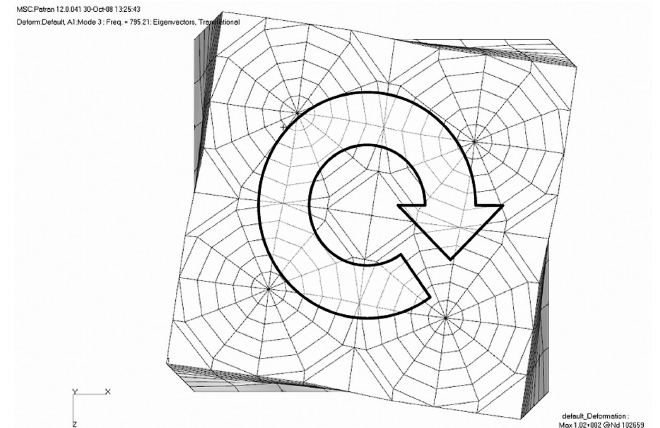
Fig. 16. 3rd mode : 781 Hz – Y symmetric rotation.